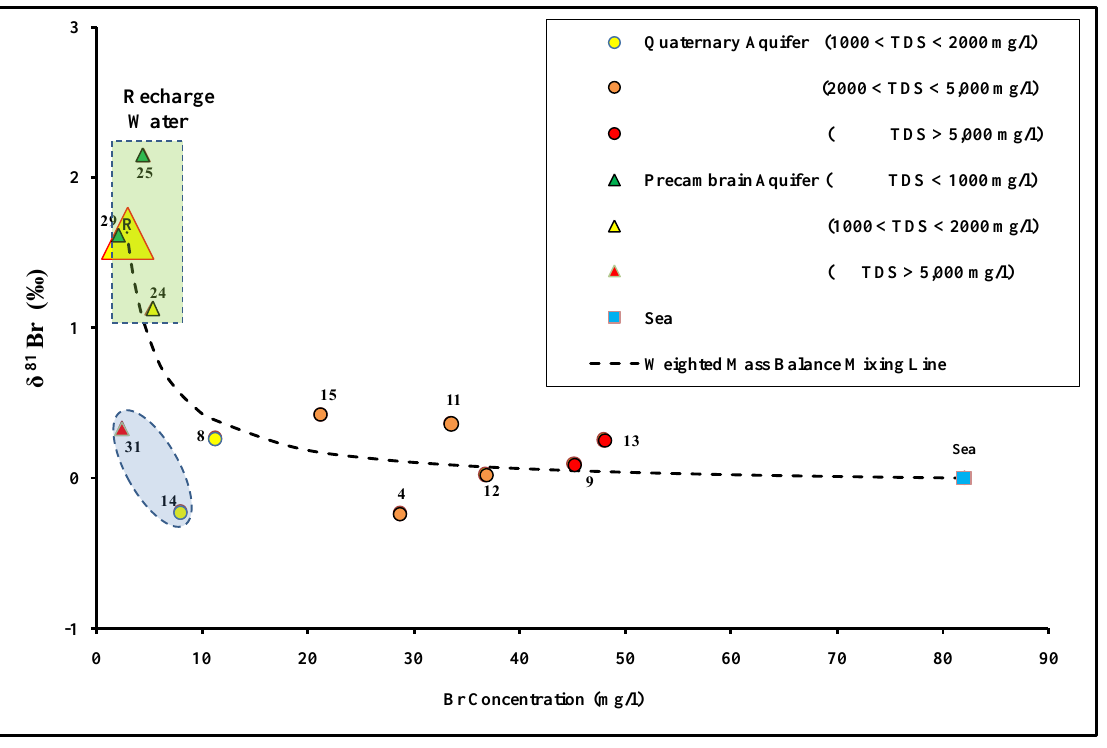
Figure 7. δ 81 Br plotted versus bromide concentrations values of the groundwater in the Dahab watershed.